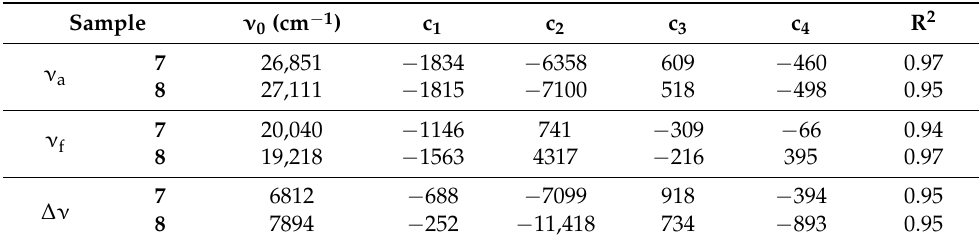
Table 7. Regression fit to the solvatochromic parameters of ν a , ν f , and ∆ ν for 7 and 8 according to Equation (9).